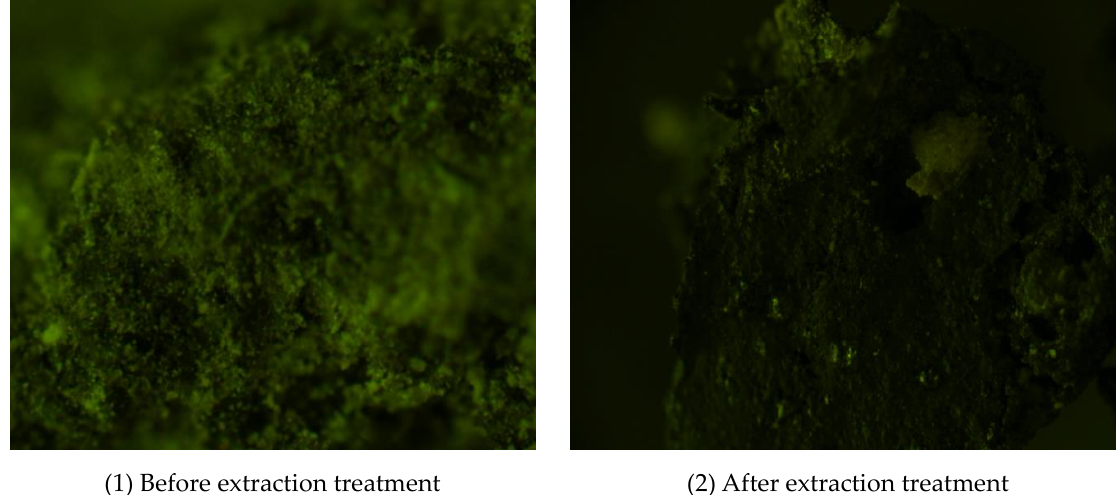
Figure 1. Fluorescence microscopic images of RAP.